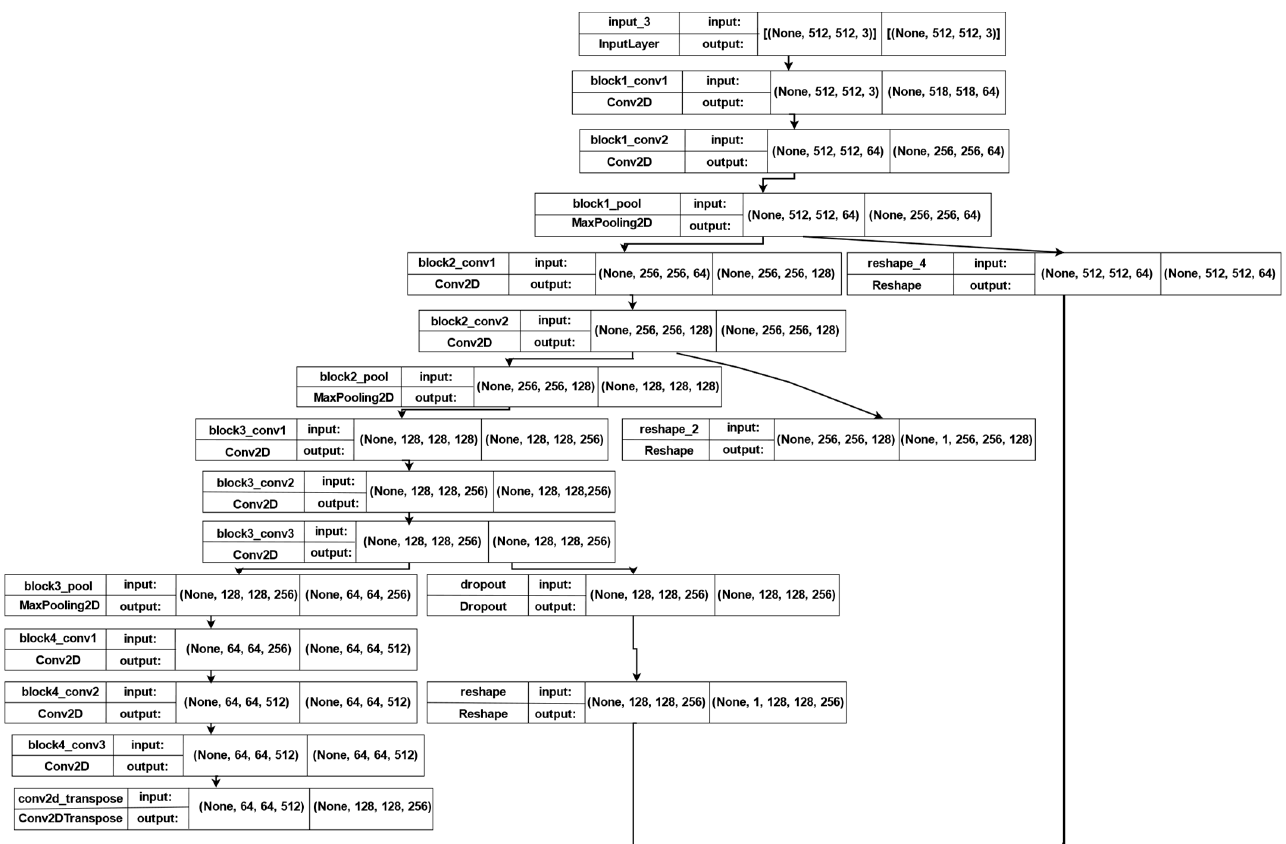
Figure 4. The first part of the architecture of the second model.